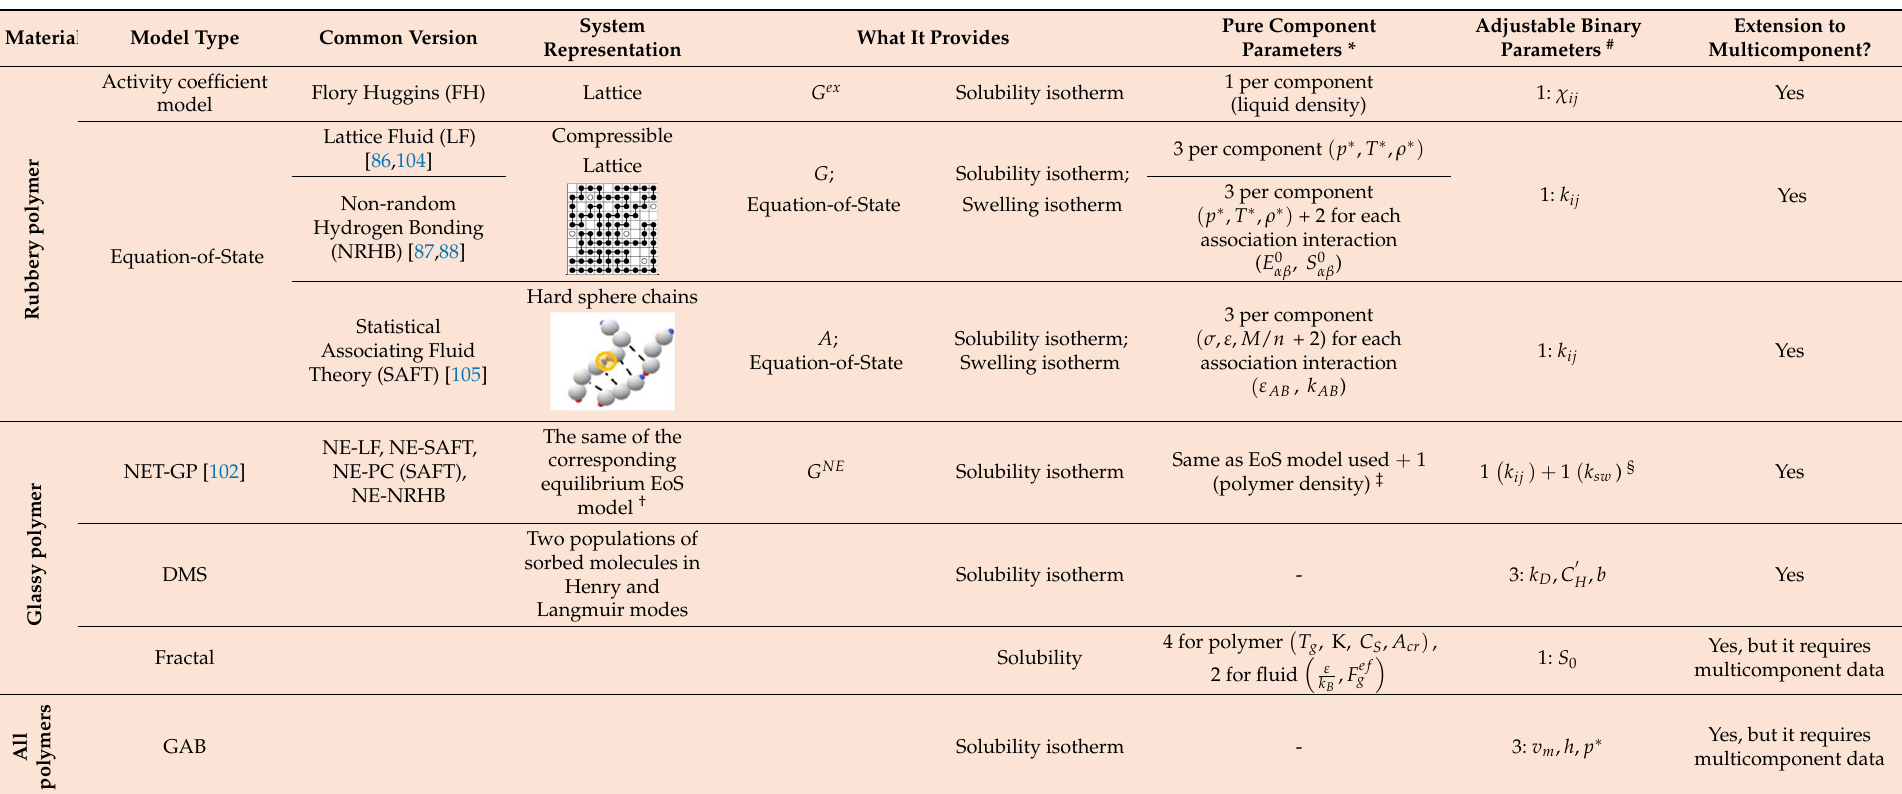
Table 1. Overview of the most-employed models for fluid solubility in polymers. The definition of all variables and symbols can be found in Appendix B.